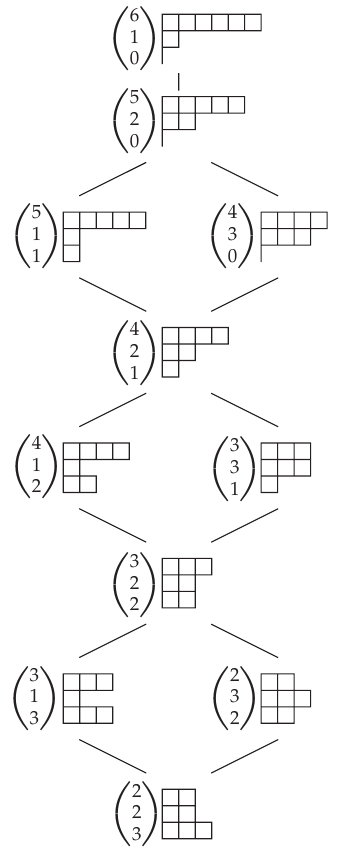
Figure 8: The set K (cid:3) x (cid:4) of Figure 7 is ordered by perm-majorization and represented by a diagram